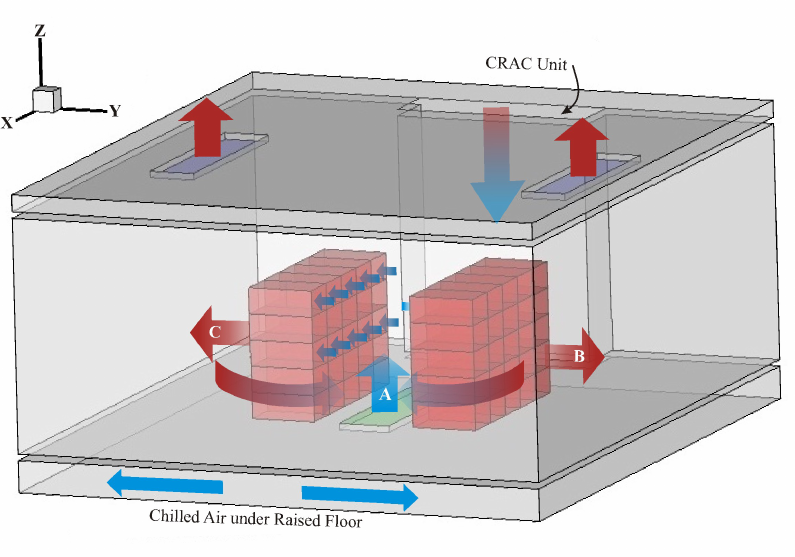
Figure 1. Data center